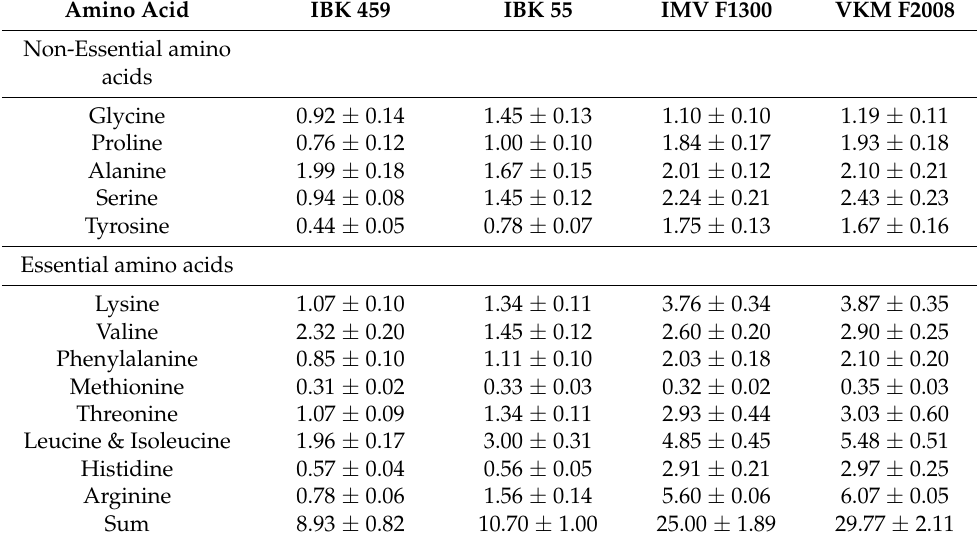
Table 3. Amino acid content in the biomass of the studied basidiomycete species, %.